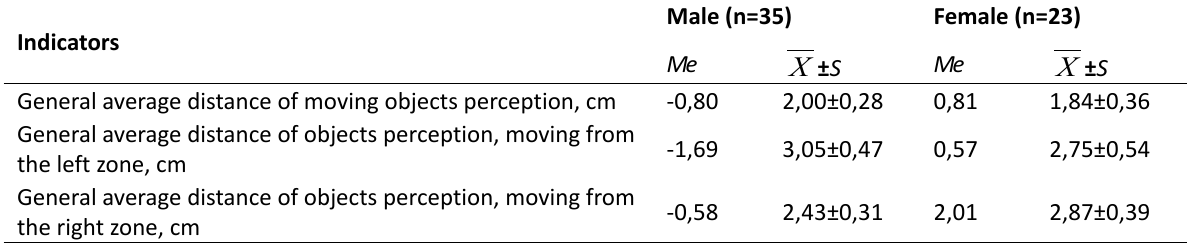
Table 1. Reaction indicators of basketball players aged 12-13 years to a moving object during binocular perception. Indicators